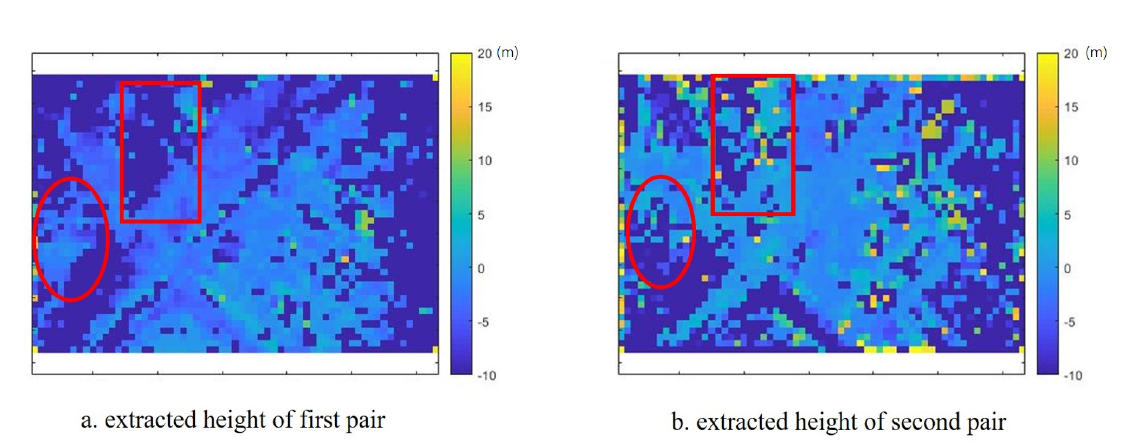
Figure 15. Preliminary elevation map of the scene generated by each pair images.